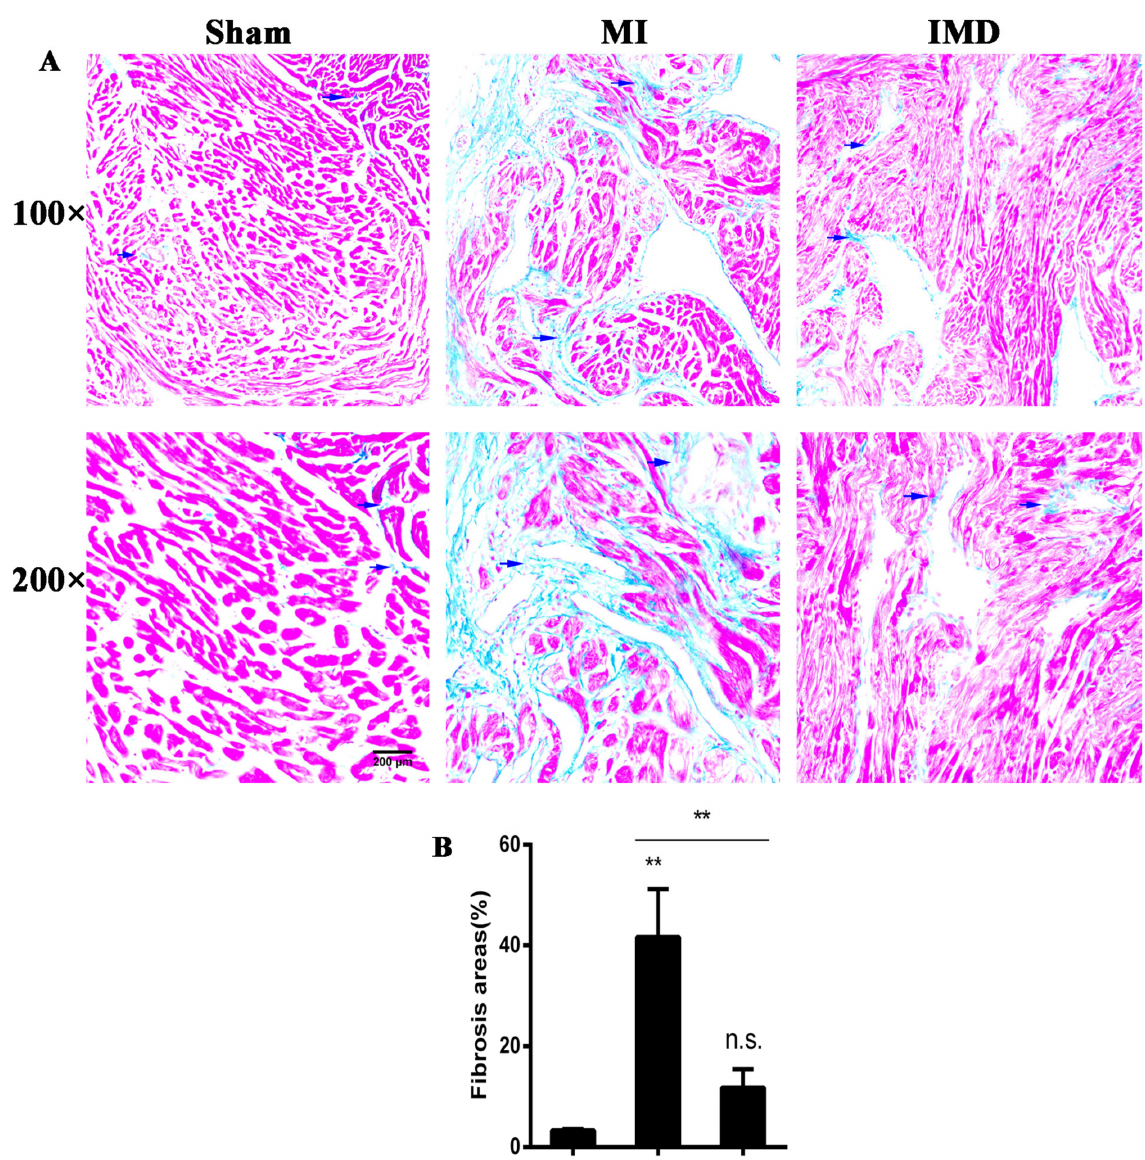
Figure 3. Effects of IMD-1-53 treatment on atrial fibrosis after MI surgery. ( A ) Representative photomicrographs of left-atrial histologic slides (Masson trichrome stain) from one rat in each group are shown at the top. The blue arrow indicates fibrosis. Scale bar = 200 µ m. ( B ) Values are presented as means ± SD. IMD1-53 reduced fibrosis area. n = 10. MI, myocardial infarction. ** p < 0.01, n.s., no